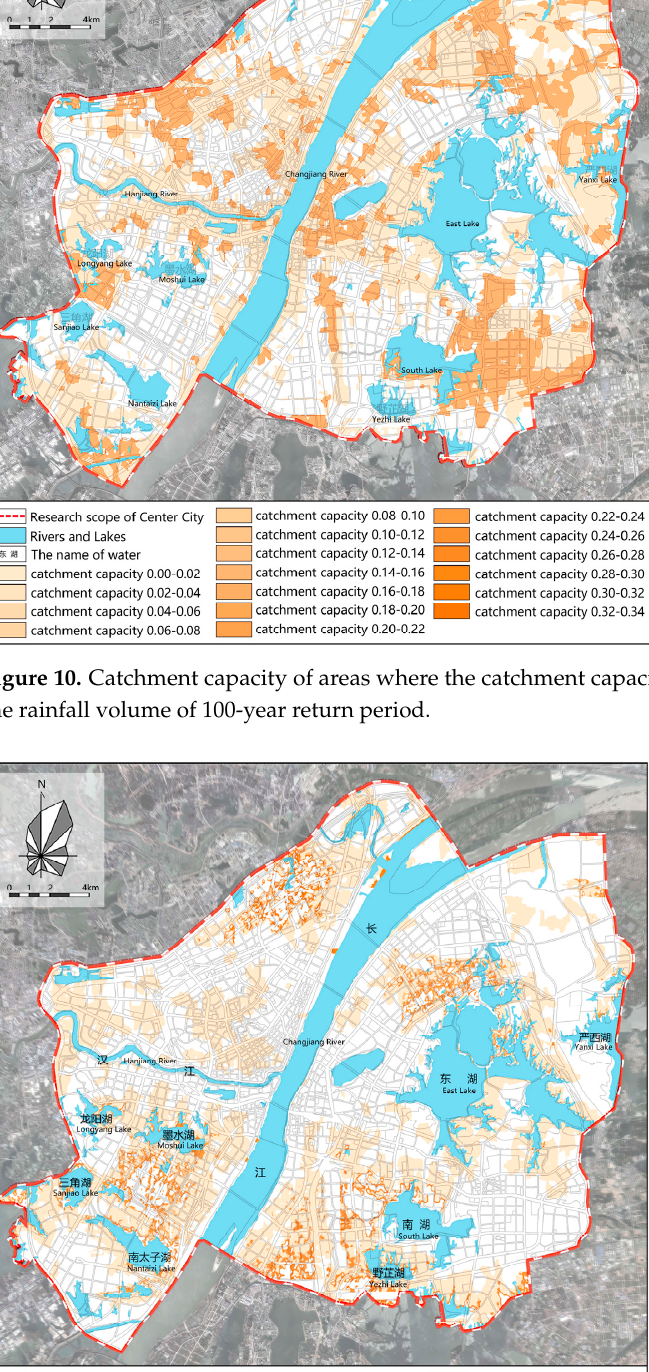
Figure 9. Simulated catchment capacity of the flood-submerged areas.